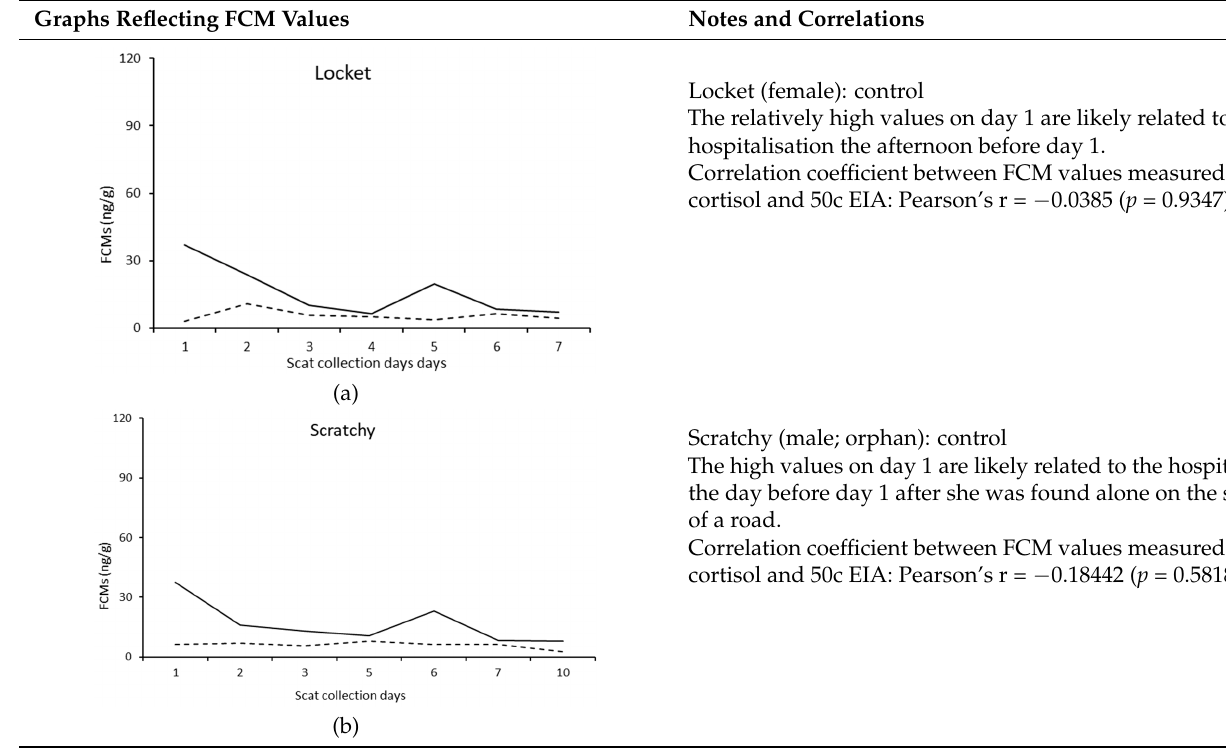
Table A2. Longitudinal study graphs showing the effect of hospital treatment on FCM (faecal cortisol metabolite) values measured by 50c (continuous line) and cortisol (dashed line) EIAs. Graphs Reflecting FCM Values